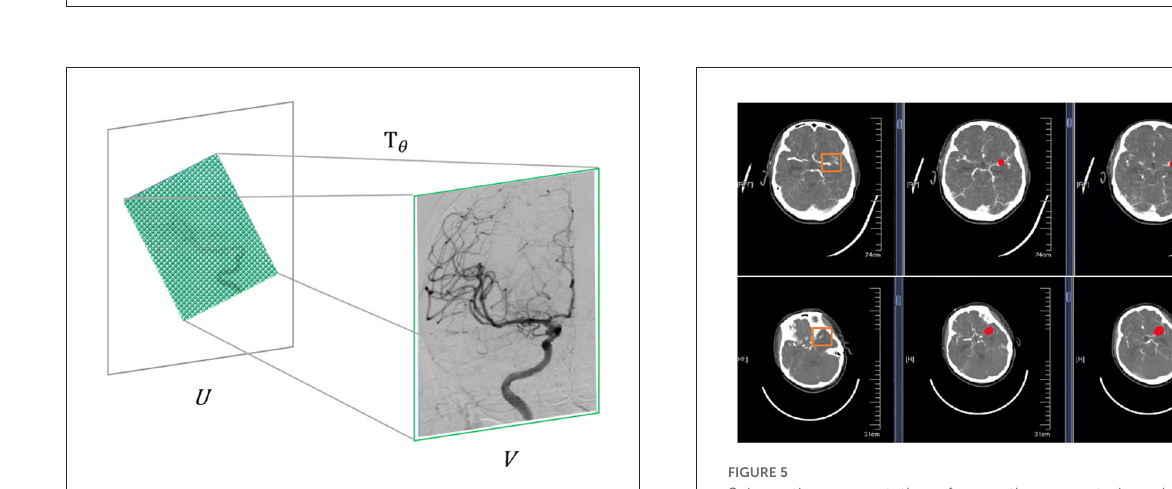
FIGURE4 Schematic diagram of the attention mechanism in the spatial domain.